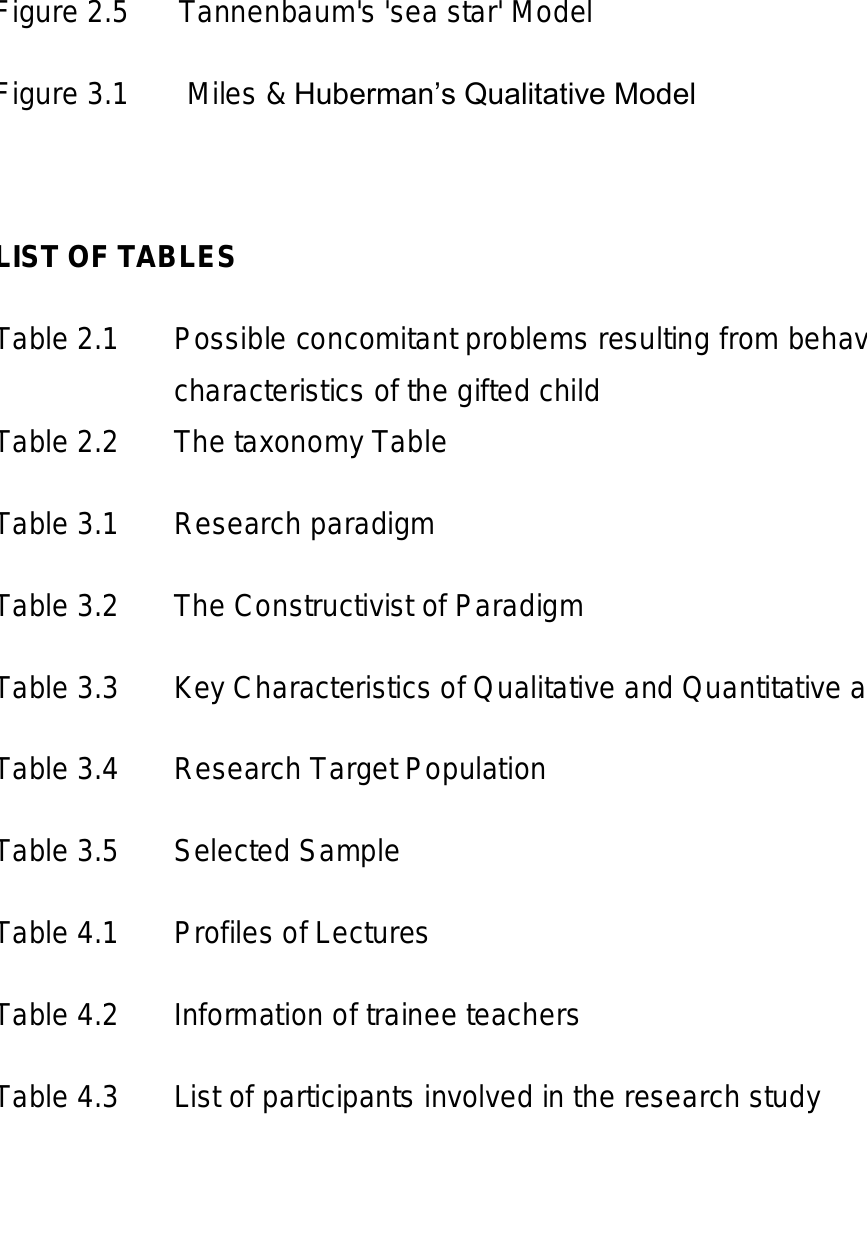
Summary of the MI Theory Framework Renzulli’s Three Ring Model Renzulli’s Three Ring Model Figure